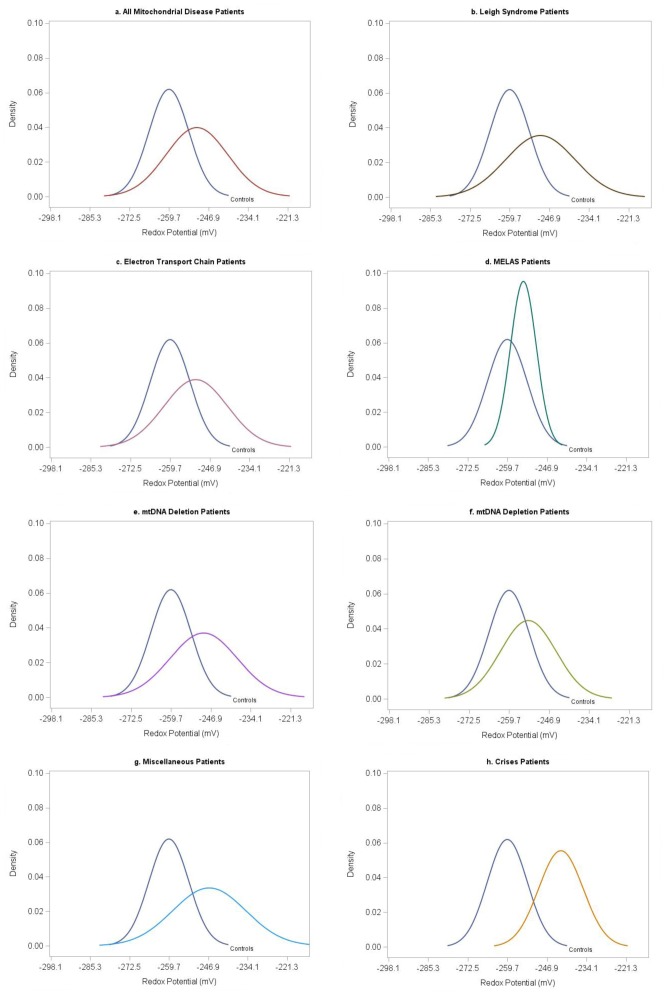
Glutathione redox potential distribution curves.The redox potential distribution curve for each mitochondrial disease subgroup is compared to the normal distribution of control redox potential in order to show how distribution of redox potential differs from the controls. a) Mitochondrial disease patients combined, excluding those in metabolic crisis; b) Leigh syndrome patients; c) Electron transport chain disorder patients; d) Mitochondrial encephalomyopathy, lactic acidosis and stroke-like episode patients; e) mtDNA deletion patients; f) mtDNA depletion patients; g) Miscellaneous mitochondrial disease patients; g) Mitochondrial disease patients hospitalized in metabolic crisis. Normal distribution plots were created with SAS 9.4. The density of the normal distribution is the height for a given value on the x-axis.